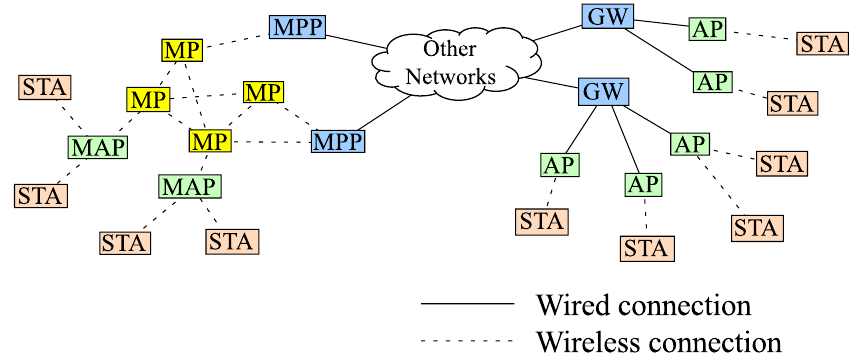
Figure 1. WMNs ( left ) vs. conventional WLANs ( right